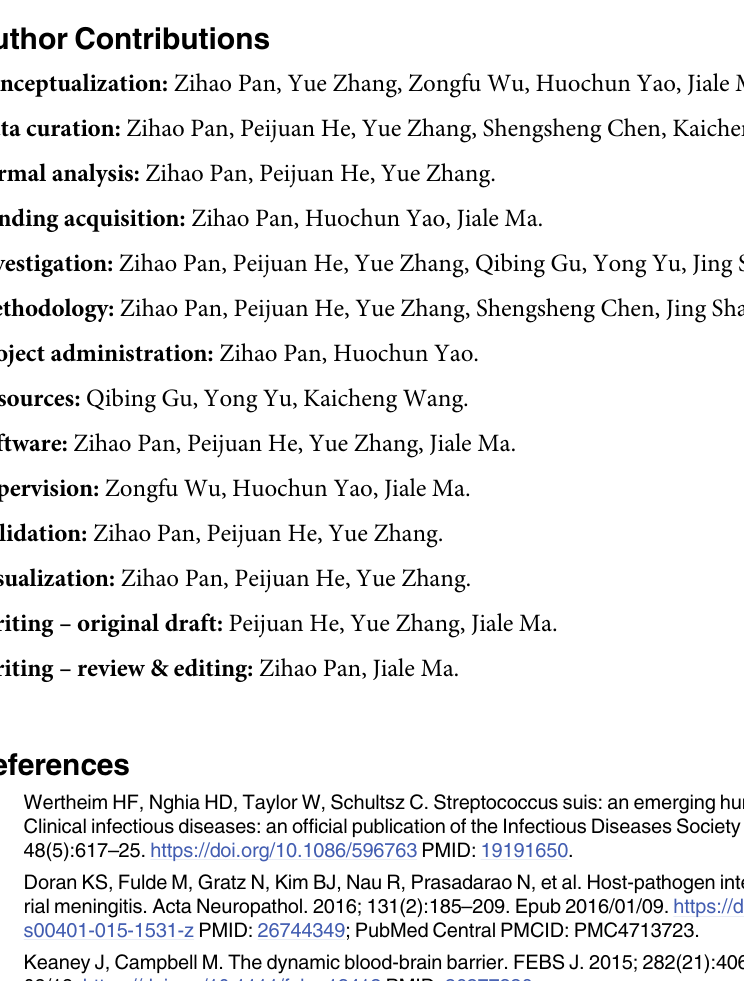
enzyme Stu1 in the plasmid pKSM410. The positive clone pKSM410-rss29 was identified and multiplicated in E . coli DH5 α . Then the pKSM410-rss29 was transformed into the strains of CZ130302 and Δ sssP1 . After identified by PCR, the positive clone strains of CZ130302 and Δ sssP1 were observed by the Carl Zeiss LSM710 microscope. S4 Fig. The bacterial adhesion assays using the sialidase (Sigma) pretreated HBMECs. The adhesion levels of the indicated S . suis strains were detected at the MOI 100:1. The hyaluroni- dase (Sigma) pretreated cells was used as control. S1 Table. Bacterial strains, plasmids, and primers used in this study. S2 Table. Analysis of protein interaction between SssP1 and HBMEC